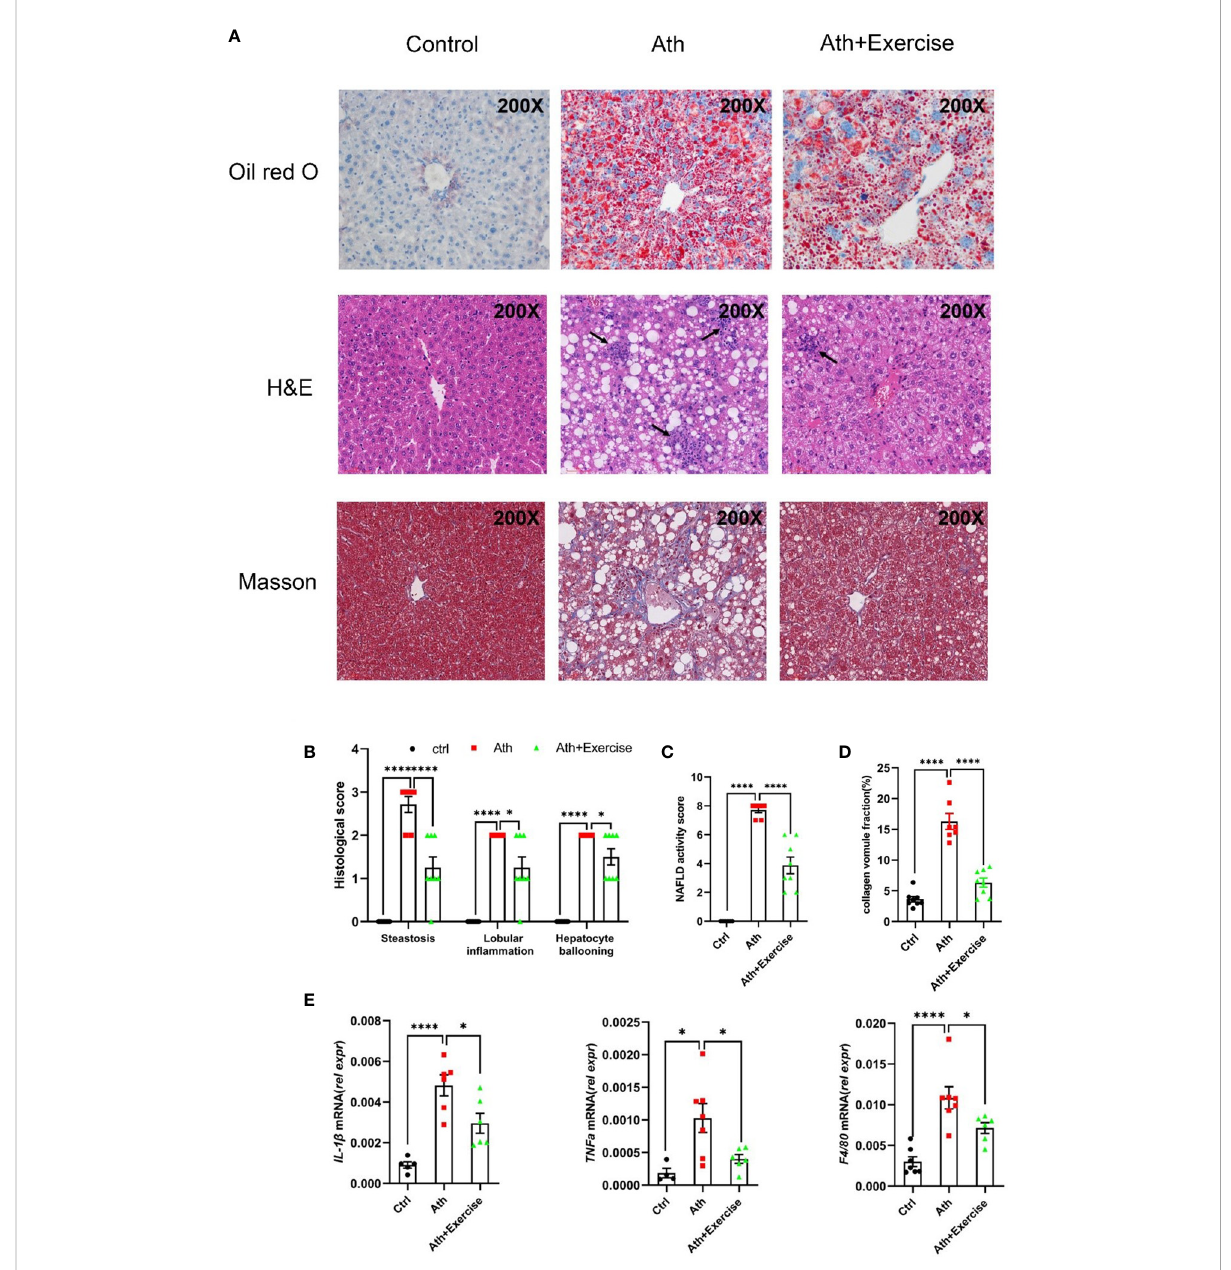
FIGURE 2 Aerobic exercise decreases hepatosteatosis, lobular in fl ammation and fi brosis in mouse livers. (A) Representative images of liver sections stained by Oil Red O, HE and Masson staining from control, NASH and NASH+Exercise mice (original magni fi cation, ×200). (B) Histological scores of steatoses, lobular in fl ammation, and hepatocyte ballooning in H&E-stained livers. (C) NAFLD activity score was calculated by the histological score of steatosis, lobular in fl ammation, and hepatocyte ballooning. (D) The collagen volume fraction by Masson staining. (E) Relative mRNA levels of IL- 1 b , TNF a and F4/80 in liver tissues from control, NASH and NASH+Exercise mice. Data are depicted in mean ± SEM. *P<0.05;